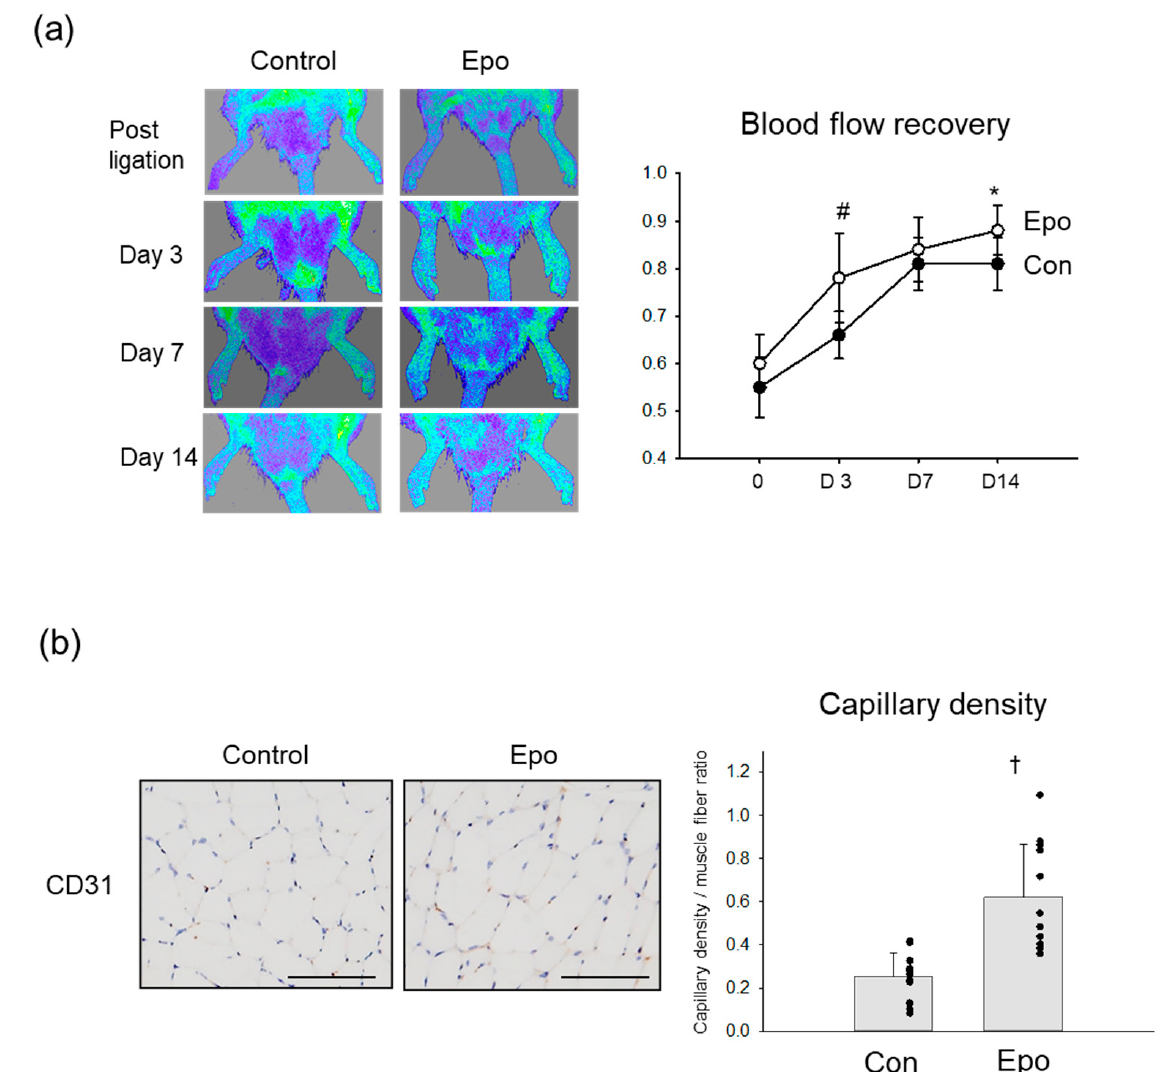
Figure 5. Angiogenic effect of Epo on rat limb ischemia. ( a ) Blood perfusion recovery assessed by LDPI. Left, representative images of LDPI. Right graph, time course changes of the LDPI indices in the Epo group and the controls. N = 11. * p < 0.05 vs. control on day 3. # p < 0.01 vs. control on day 14. ( b ) Left images, immunohistochemistry was performed using CD31 antibody to evaluate the capillaries in skeletal muscle on day 14. Right graph, comparison of the capillary density between the ischemic limbs treated with and without Epo. N = 11. † p < 0.001. Bar = 200 µm.